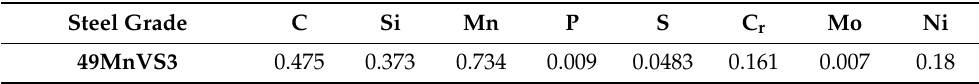
Table 3. Chemical compositions of crack sample (wt. %).